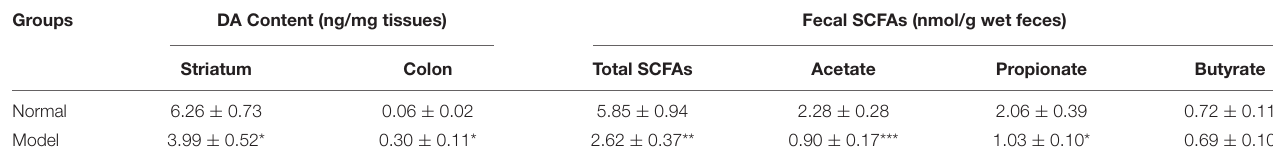
TABLE 1 | Striatal and colonic dopamine (DA) content and fecal short chain fatty acids (SCFAs) levels in normal and model mice of Parkinson’s disease (PD) a , b . Groups